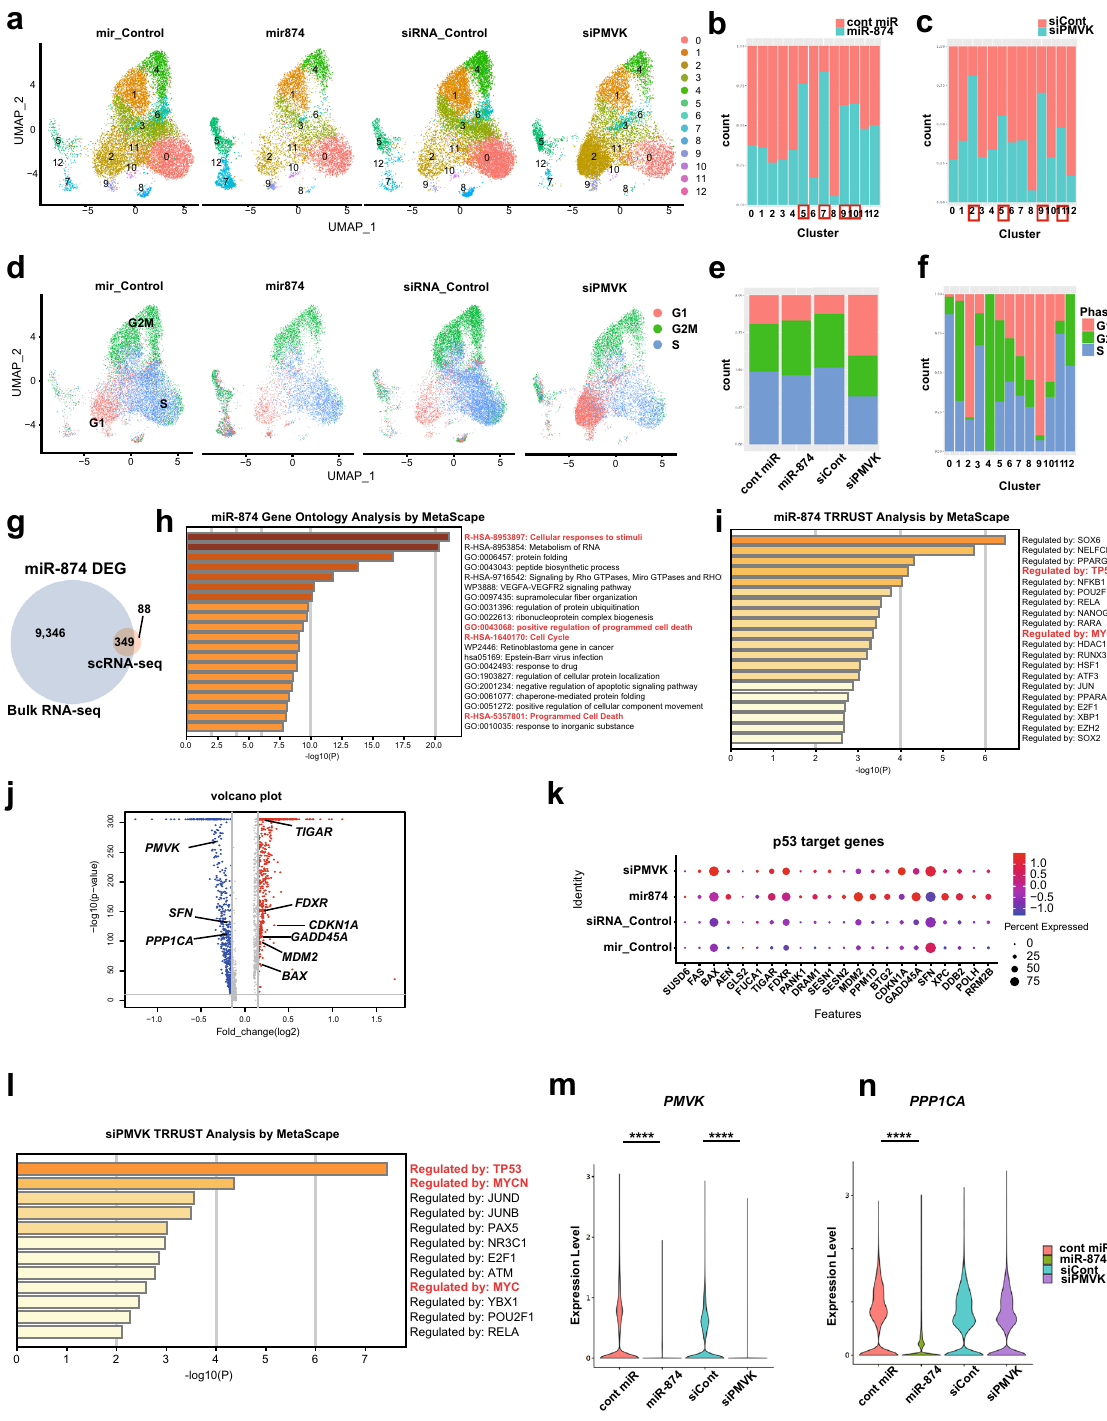
Figure 4. scRNA-seq revealed that miR-874 downregulates PMVK and upregulates p53 target genes in MCF-7 cells. MCF-7 cells were transfected with control (cont) miRNA or miR-874 for 36 h or control siRNA or siPMVK for 48 h. The viable population of MCF-7 cells was sorted, and each of the four groups was profiled by droplet-based scRNA-seq. ( a ) scRNA-seq data (n = 46,130) across all four groups of treated MCF-7 cells are shown as nonlinear representations of the top 50 principal components. Cells are coloured according to UMAP-based clusters. ( b , c ) Proportions of each cluster from miRNA ( b ) or siRNA transfections ( c ). Clusters increased by miR-874 ( b ) or siPMVK transfection ( c ) are marked with red frames. ( d ) Cells are coloured according to UMAP-based clusters of cell phase, according to treatment. ( e , f ) Proportions of the cell phase within each group ( e ) or cluster ( f ). ( g ) Venn diagram showing 349 common differentially expressed genes (DEGs) among 9695 genes identified by bulk RNA-seq and 437 identified by scRNA-seq between cells transfected with cont miRNA and miR-874 . ( h ) The table shows multiple pathways enriched in 349 common DEGs analysed by Metascape. ( i ) The table shows the prediction of upstream transcription factors among the DEGs by TRRUST analysis in Metascape. ( j ) Volcano plots showing DEGs between cont miRNA and miR-874. ( k ) Dot plot showing p53 target genes. ( l ) The table shows the prediction of upstream transcription factors from the DEGs between control siRNA and siPMVK by TRRUST analysis in Metascape. ( m , n ) Violin plot of the miR-874 targets PMVK ( m ) and PPP1CA ( n ) in each group (****p < 0.0001; Welch’s t